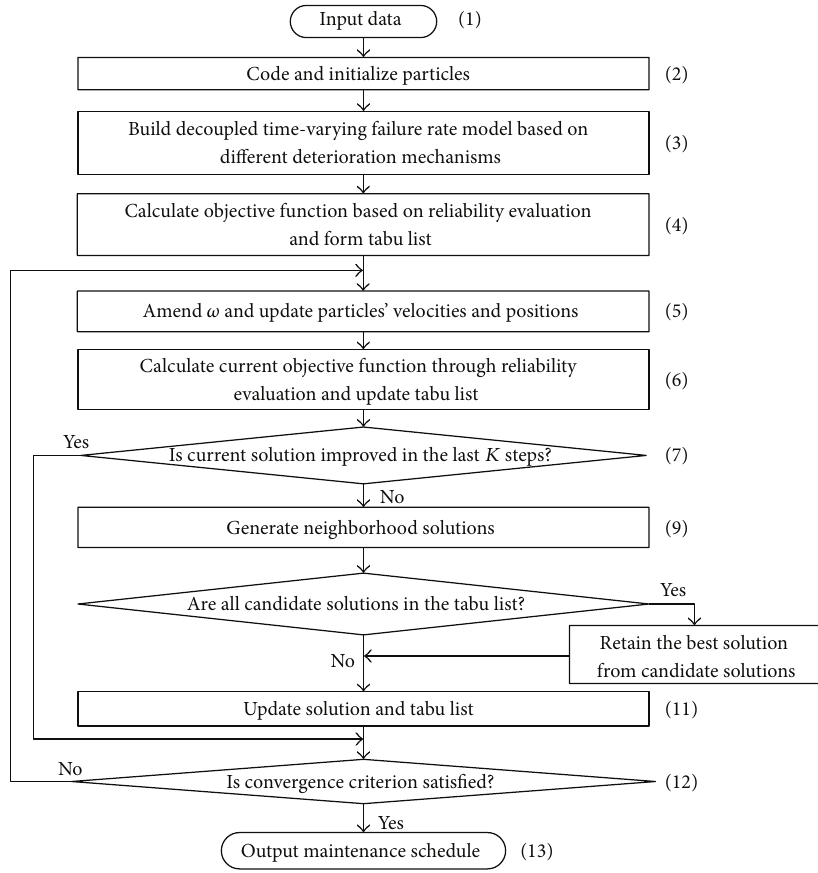
Figure 3: The solving flow chart through the PSO-TS hybrid algorithm for maintenance